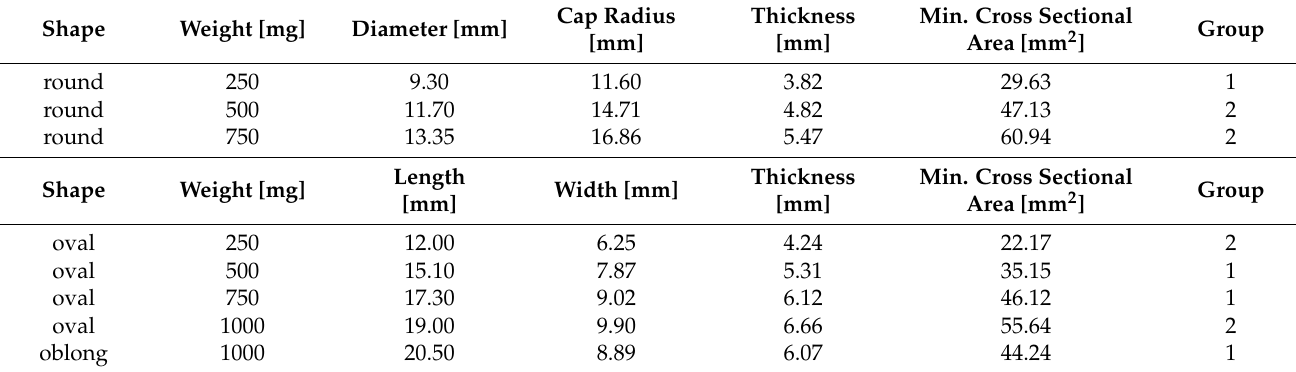
Table 1. Description of tablets’ characteristics. The group assignment refers to the experimental groups in the deglutition assessment (Section